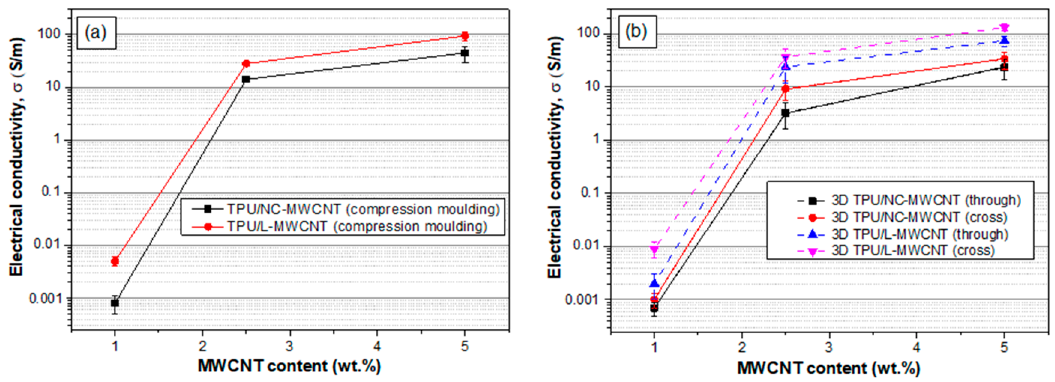
Figure 6. ( a ) Electrical conductivity of TPU/NC-MWCNT and TPU/L-MWCNT thermal-pressed nanocomposites at 1.0, 2.5 and 5.0 wt.% MWCNT content (at “in-plane” direction of the